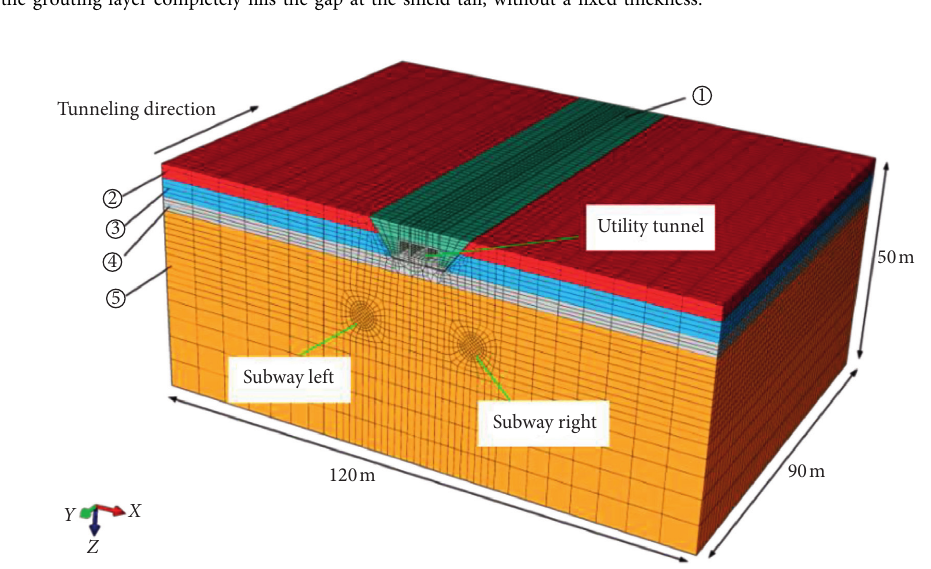
Figure 4: Numerical model of engineering.